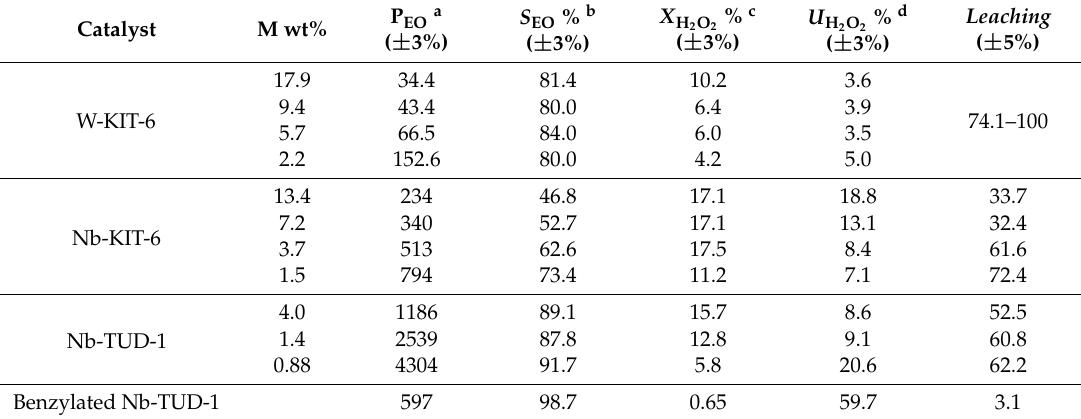
Table 3. Epoxidation activity of ethylene over M-KIT-6 and Nb-TUD-1 catalysts (reaction